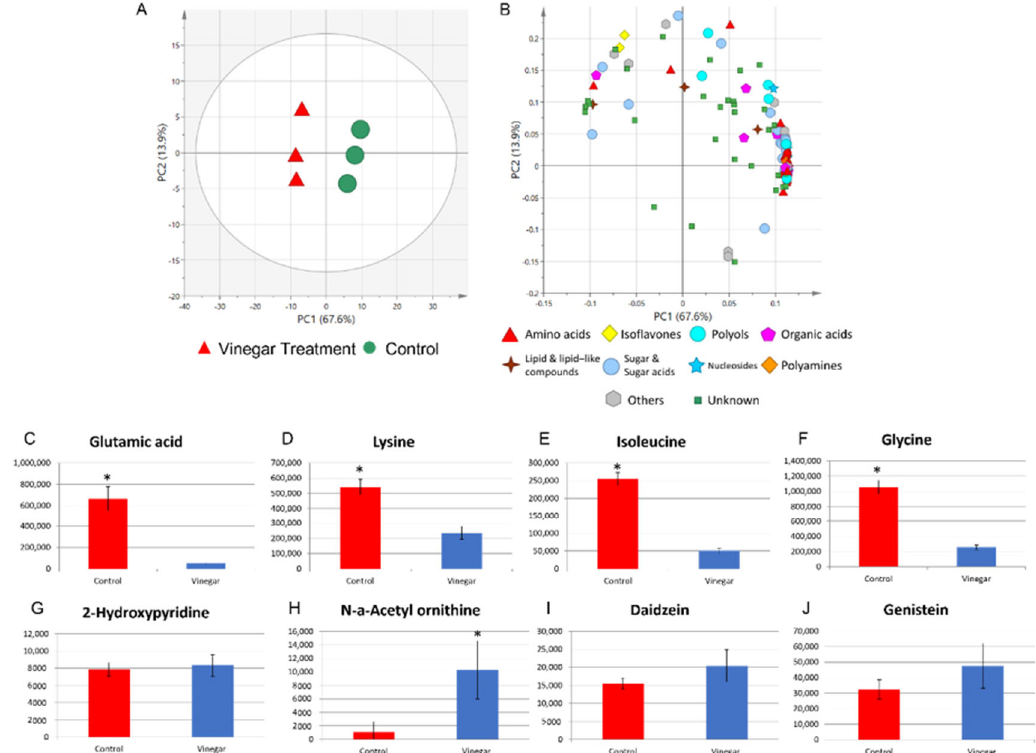
Figure 5. Principal component analysis of tempe soaked without and with vinegar and bar graph of selected metabolites. ( A ) Score and ( B ) loading plots of tempe soaked without (control) and with vinegar. Bar graph shows relative intensity of ( C ) glutamic acid, ( D ) lysine, ( E ) isoleucine, ( F ) glycine, ( G ) 2-hydroxypyridine, ( H ) N- a -acetylornithine, ( I ) daidzein, and ( J ) genistein. * p < 0.05 (significantly different, Student’s t